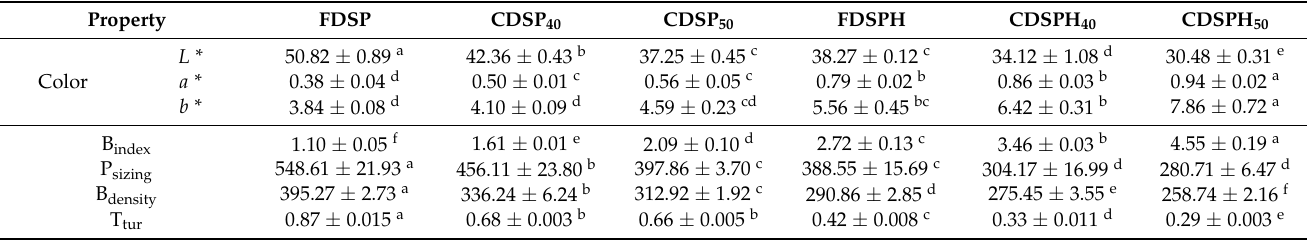
Table 1. Physical traits of freeze and convectively (oven)-dried SP and